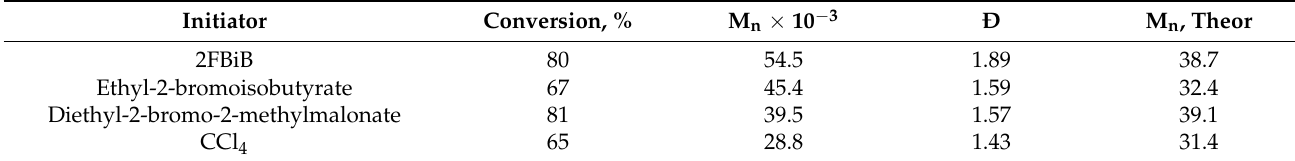
Table 1. The results of polymerization of acrylonitrile in the presence of CuBr 2 /PMDTA and different initiators. Time—20 h.